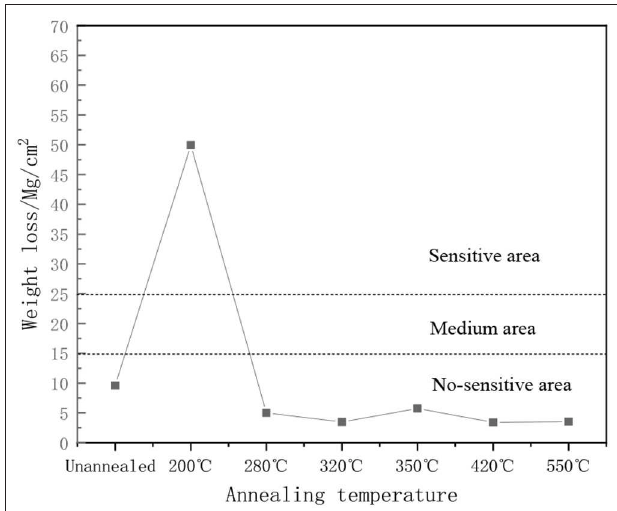
FIGURE 3 | The intergranular corrosion of the Sc-containing alloy annealed at different temperatures (including cold rolling sample) using the weight loss method.